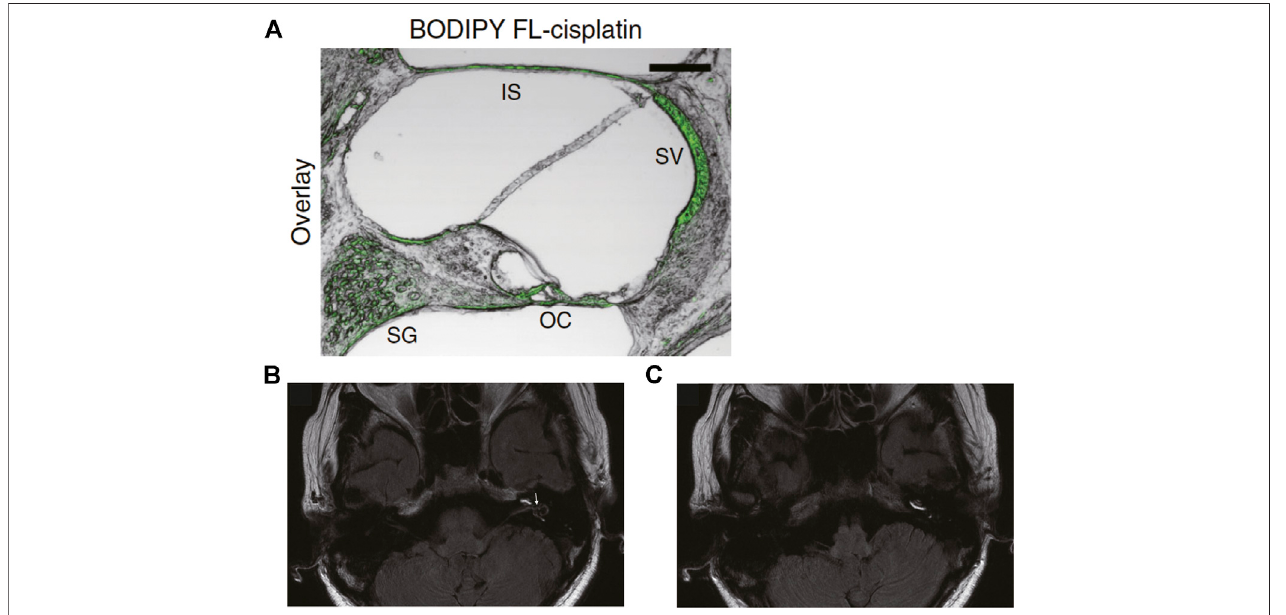
FIGURE3| Invivo imaginganalysesofthecochlea. (A) Confocalimageofaslicefromcochlearcryosectionsofmicesystemicallyadministeredcisplatinconjugated with a green fl uorescent dye, BODIPY FL. The green signal indicates cisplatin accumulation. SG: spiral ganglion, OC: organ of Corti, SV: stria vascularis, IS: interscalar septum. Adapted from Breglio et al. (2017) with permission from Springer Nature. Copyright (2017) Nature Communications. (B,C) Three-dimensional magnetic resonance images taken 1 day after intratympanic injection of gadolinium in a patient with Meniere ’ s disease. (B) Gadolinium signals are observed in the perilymphaticareaofthebasalandsecondturnsofthecochlea,aswellasinthevestibuleandsemicircularcanals.Largeblackareasinthevestibulerepresentvestibular endolymphatic hydrops (arrow). (C) The same image scanned at a different cross-section. The scala tympani of the three turns of the cochlea are clearly visualized by gadolinium. Adapted from Nakashima et al. (2007) with permission from John Wiley and Sons. Copyright (2007) The Laryngoscope.